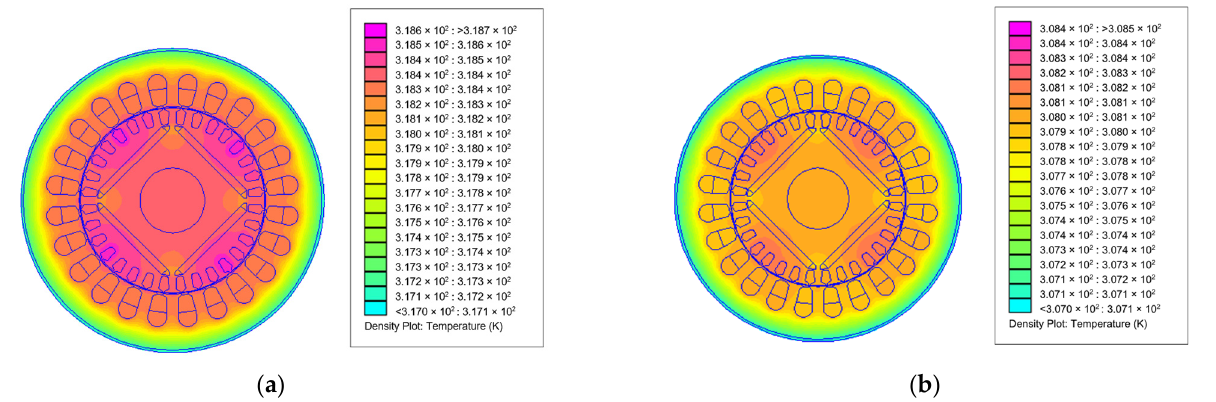
Figure 15. Temperature distribution (in Kelvin) in the motor from the FEMM thermal simulation for: ( a ) second-order voltage harmonic and ( b ) fifth-order voltage harmonic. ( a ) second-order voltage harmonic and ( b ) fifth-order voltage harmonic.